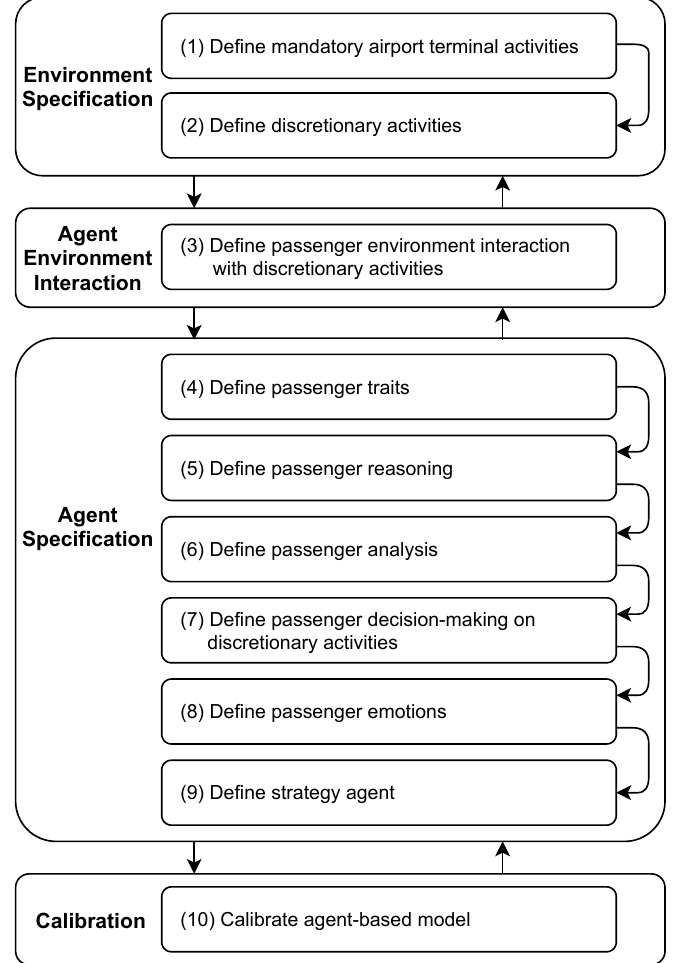
Figure 1. Methodology